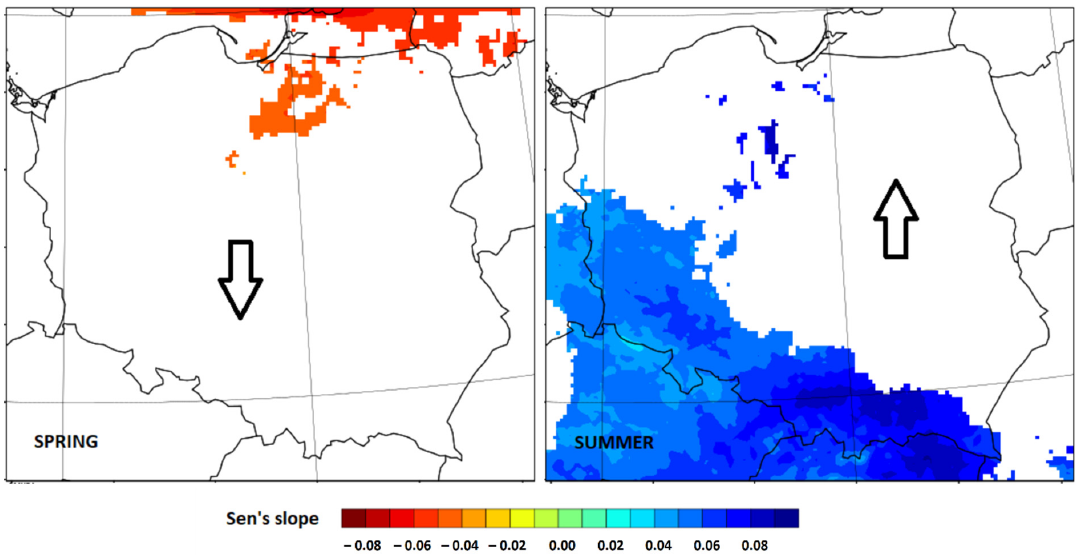
Figure 13. Sen’s slope for significant trends ( α = 0.05) of average spring and summer PW over Poland in the years 1983–2010. The arrows show direction of PW changes over the area of Poland without statistically significant trends. B